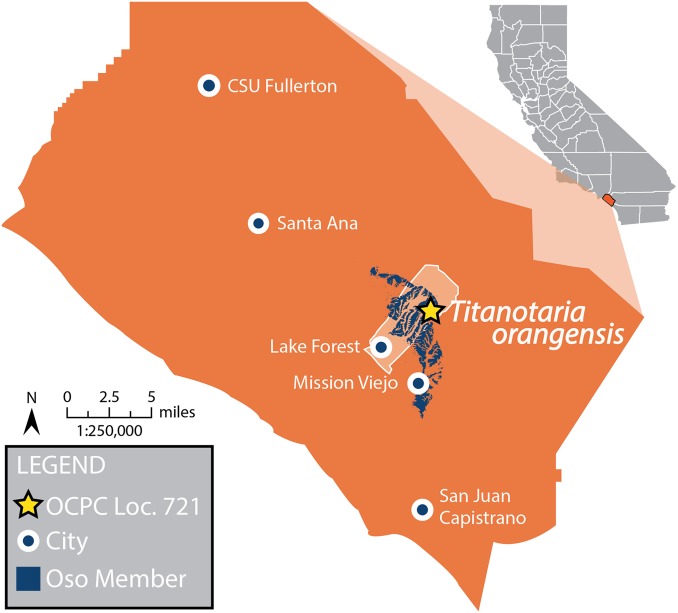
Map of Orange County, CA, and type locality for Titanotaria orangensis.Map of Orange County, California, showing where OCPC 11141 was discovered in the Oso Member (extent shown in blue) of the Capistrano Formation, Lake Forest (outline in white), Orange County (in orange), California. A star represents the locality (OCPC Locality 721) of Titanotaria orangensis (OCPC 11141). Map modified from Barboza et al. (2017).